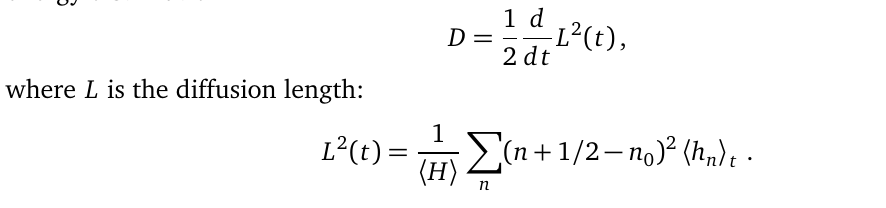
(cid:112) t behavior expected from conventional